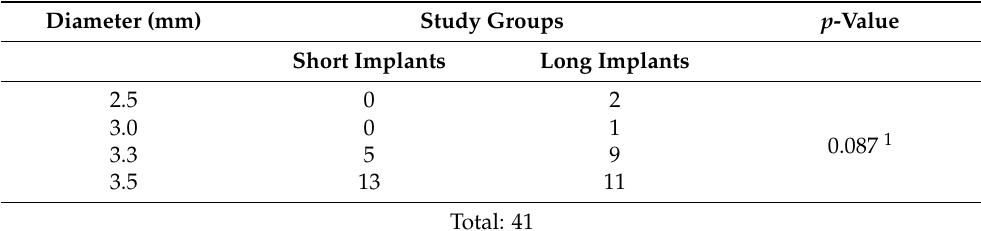
Table 1. Diameter of the short and long implants.